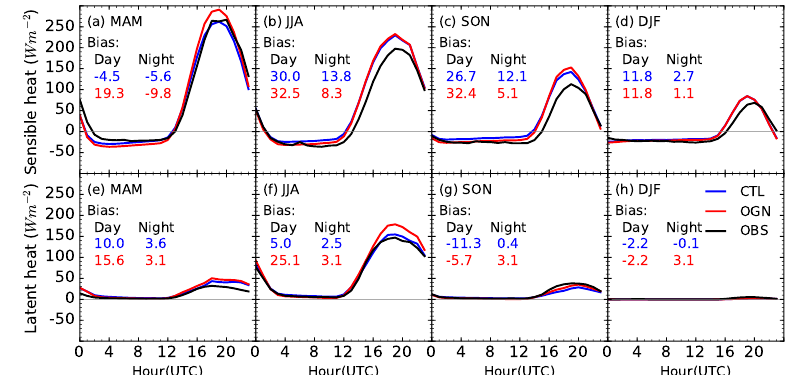
Figure 8. Comparison of the seasonal averaged diurnal cycle of the sensible and latent heat fluxes at OAS site for drought years.